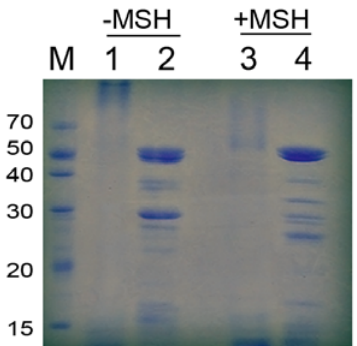
Figure 4. Pancreatin analyzed on an SDS-PAGE gel with or without MSH. Lanes 2 and 4 were heated before SDS-PAGE analysis.